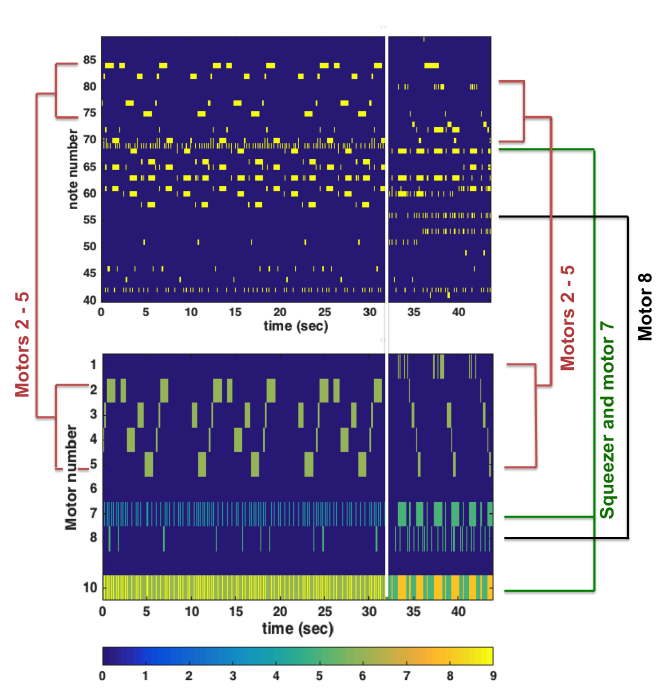
Figure 4. Tactile mapping for music sample M3, “Ashes to Ashes” onto the Pump-and-Vibe interface. Top panel: Section of notes extracted from original MIDI file. Bottom panel: Tactile mapping for this sample. Colour indicates intensity for motors 1–8, 1 being closest to the wrist and 8 closest to the elbow, and the squeezer is labelled 10. The white line separates a transition in the music that was reflected by altering the mapping between the two